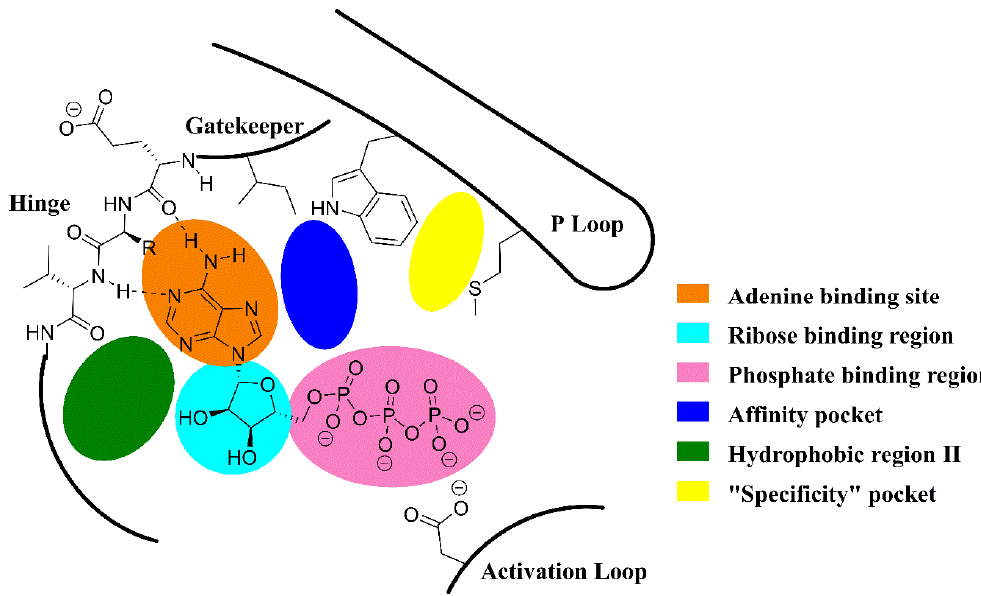
Figure 4. General model for the design of PI3K inhibitors [18,19].